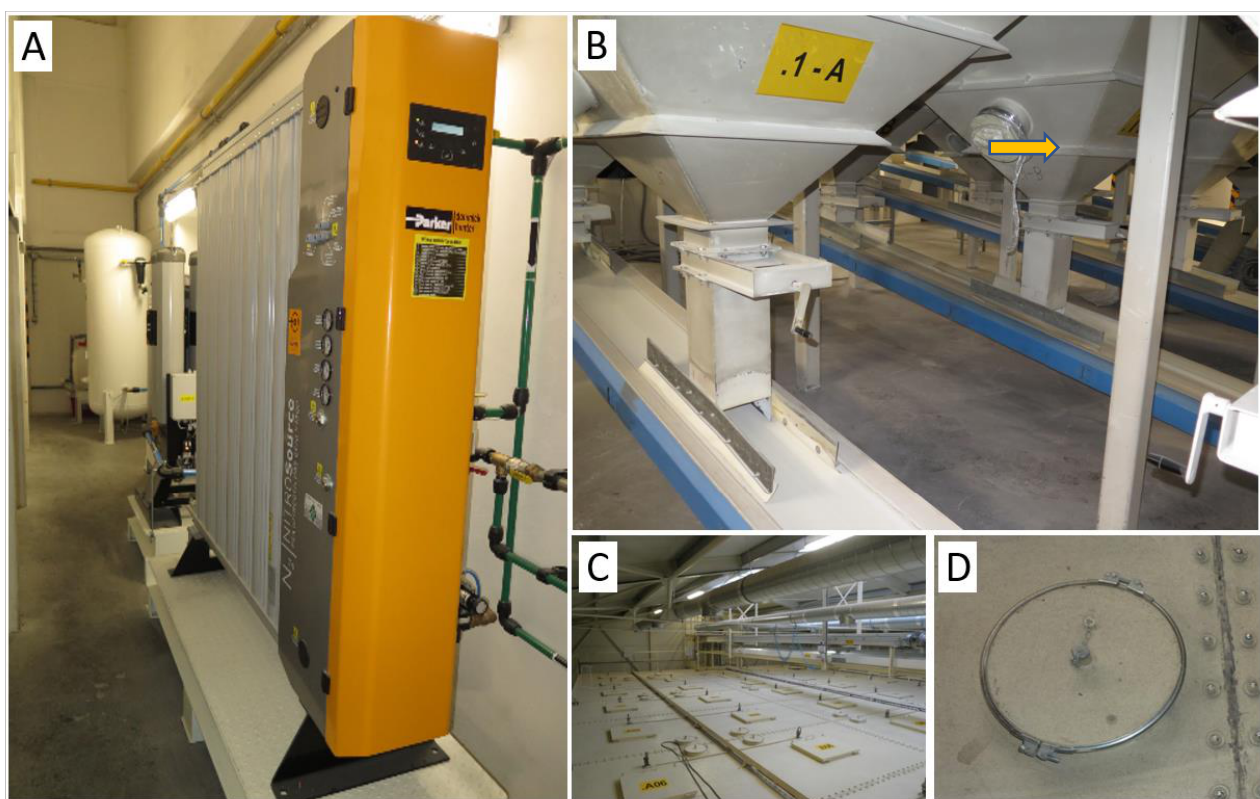
Figure 2. Visualisation of the validation of biological efficacy of nitrogen-controlled atmospheres in silos. ( A ) — the on-site- build pressure swing nitrogen generator (N 2 — NITRO Source PSA — Parker) consisting of compressor, air receiver, adsorption dryer, nitrogen buffer vessel, low pressure N 2 storage unit and piping; ( B ) — hermetic removable discoid panel at the bottom of the silo with a hole and plug for nitrogen/oxygen measures; ( C ) — top board of silo bins with rectangular opening for loading the commodity and discoid panels; ( D ) — detail of a hermetic discoid panel with plug for nitrogen filling at the top of the silo.